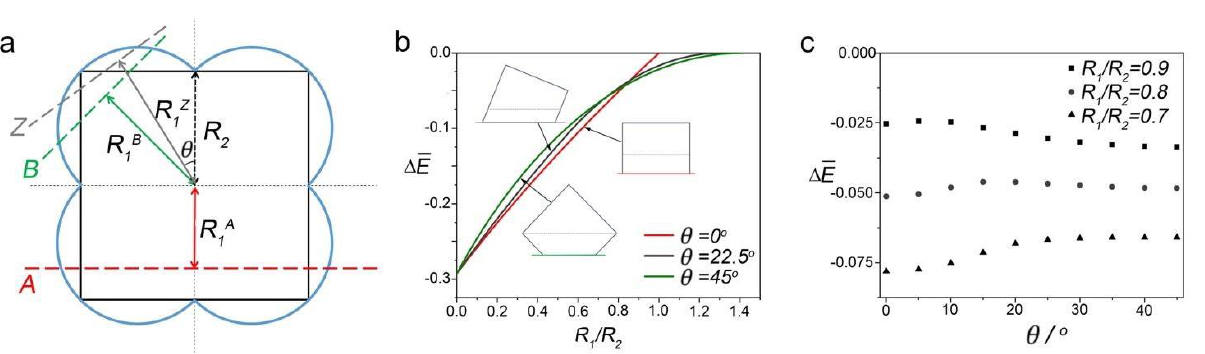
Figure 1. Equilibrium shape and the change in the total energy of a two-dimensional particle. ( a ) the schematic diagram of Wulff – Kaishew construction; ( b ) The evolution of the change in the normalized total energy ∆𝐸 ̅ with the R 1 / R 2 ratio for selected orientations; and ( c ) the evolution of ∆𝐸 ̅ with interface orientation for given R 1 / R 2 ratios.